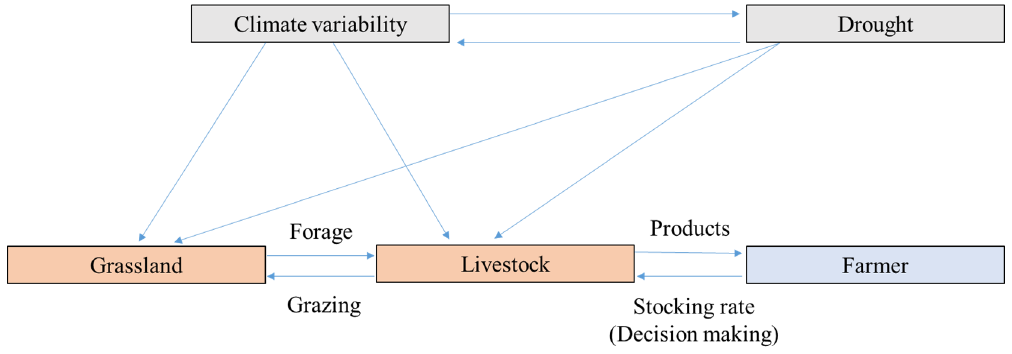
Figure 1. The relationships among climate variability, drought, and grassland ecosystems.